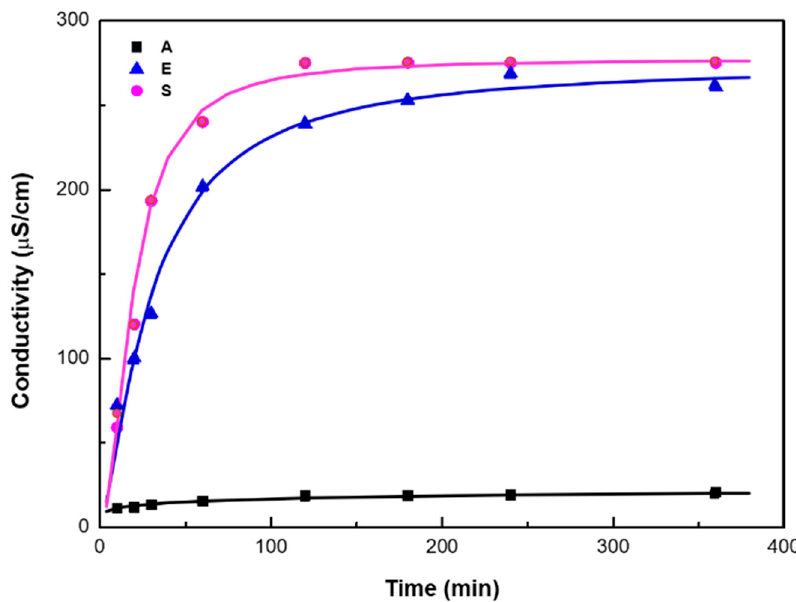
Figure 3. Micronutrient release study of the different matrices in water: accumulation of conduc ‐ tivity with time. with time.